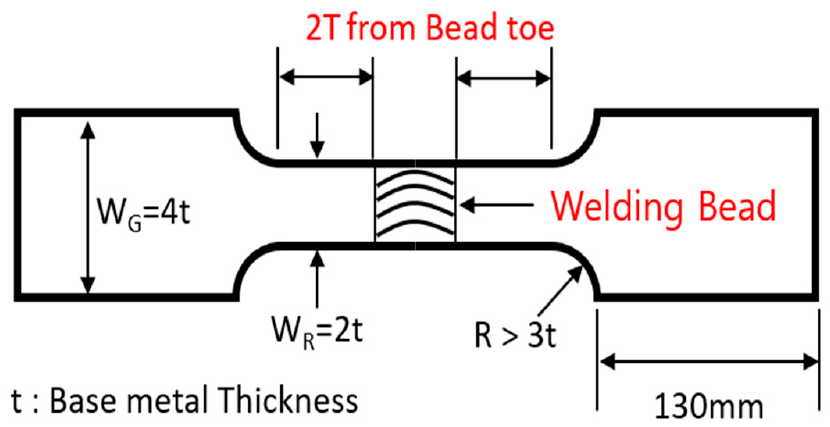
Figure 19. Shape and dimensions of the fatigue test specimens.